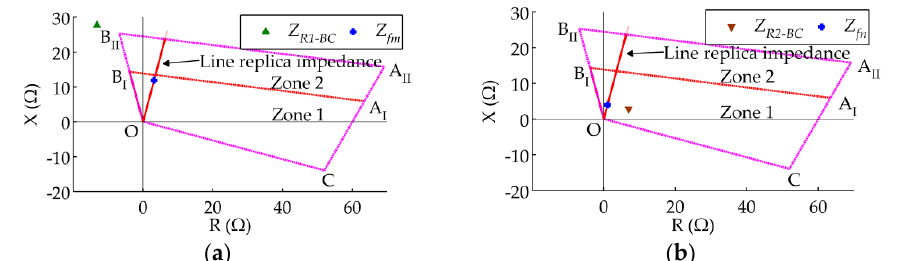
Figure 9. Measured impedances of the BC elements in R1 and R2: ( a ) Measured impedance of the BC element in R1; ( b ) Measured impedance of the BC element in R2.